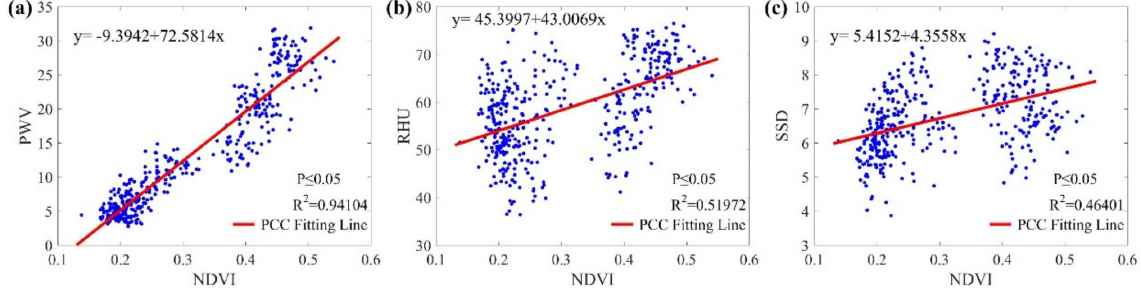
Figure 9. Correlations of NDVI with ( a ) PWV, ( b ) RHU, and ( c )